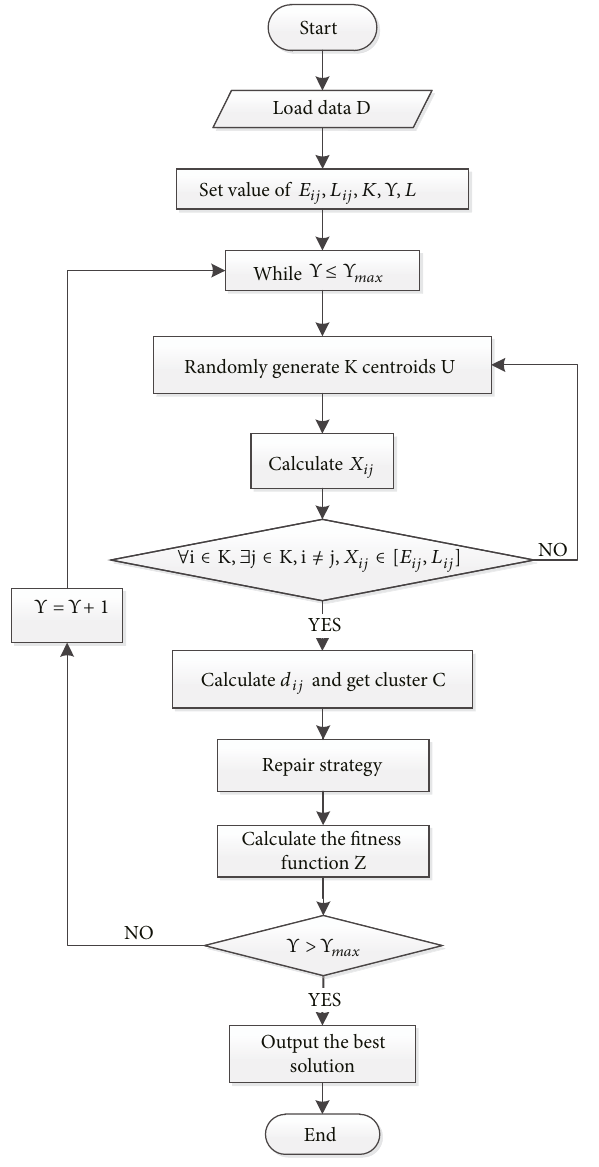
Figure 3: Flowchart of clustering algorithm.